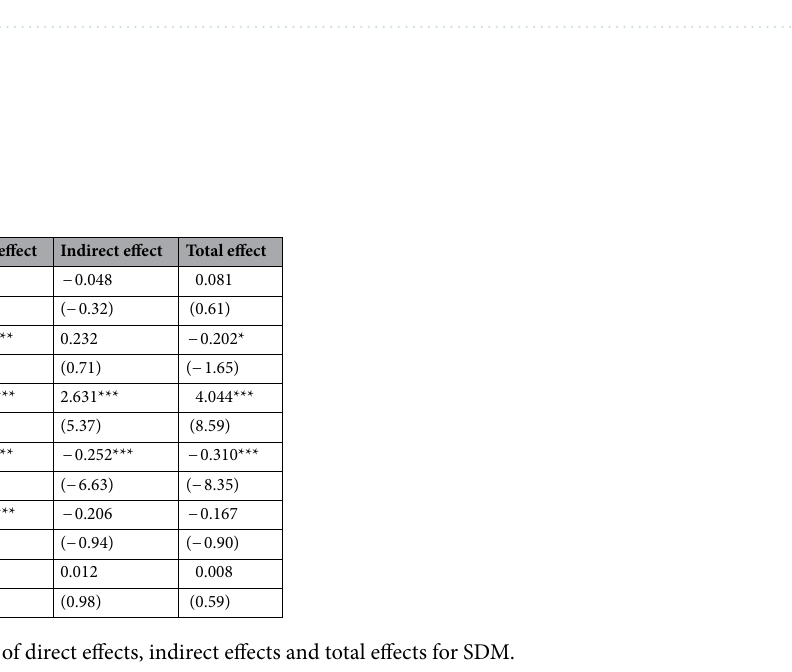
Table 8. Results of the spatial panel data model. ***, **and * indicate the significance at 1%,5% and 10% levels respectively.